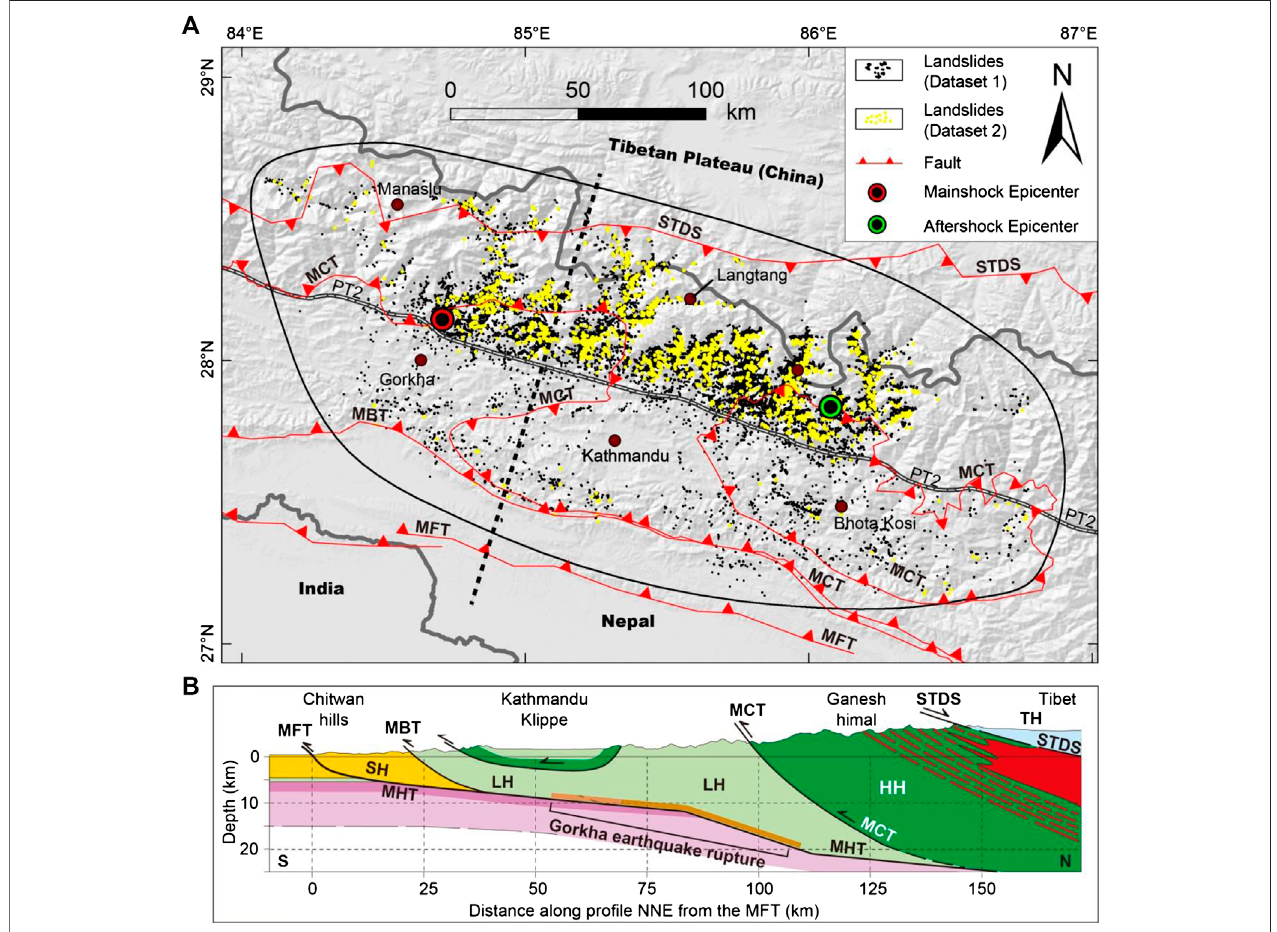
FIGURE 1 | (A) Digital elevation model that highlights the main tectonic structures that traverse the study area (outlined by the quasi-ellipse by the thin black line) and distribution of the 2015 earthquake-triggered landslides and the Gorkha earthquake and its Mw 7.3 aftershock. (B) Simpli fi ed cross-section across the